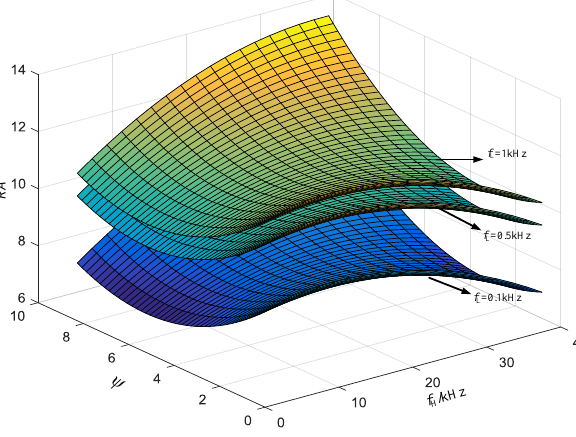
Figure 9. Response surface on ratio of reduction in area ( RA ).